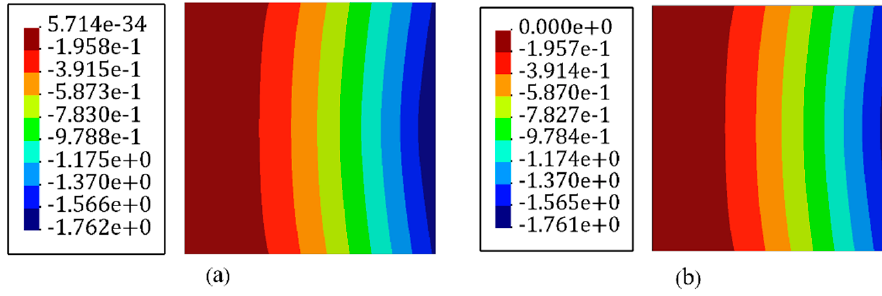
Figure 6. Deflection contours of the plate shown in Figure 4. ( a ) FEM analysis and ( b ) iFEM analysis using the full-sensor placement model.